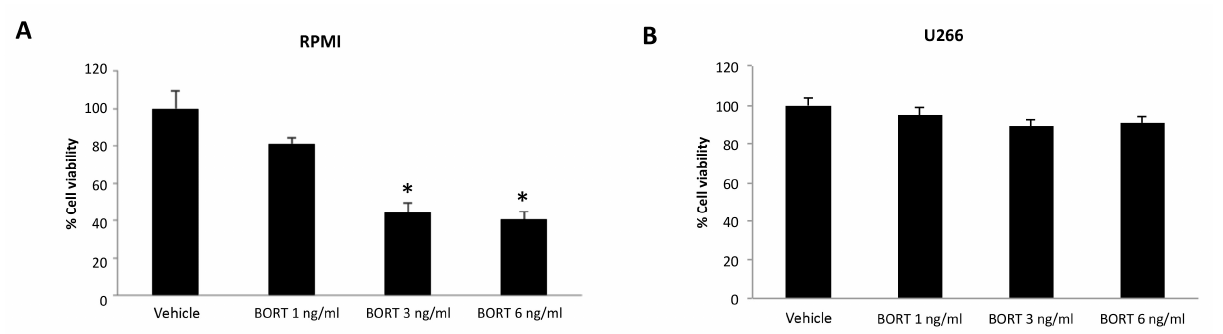
Figure 5. Cell viability assay in RPMI ( A ) and U266 ( B ) treated for 48 h with Bortezomib (BORT). Data are the mean ± SD of three different experiments. * p < 0.05 vs. vehicle-treated cells. Furthermore, we evaluated the effects of Bortezomib-Ibrutinib combination in both MM cell lines. U266 and RPMI cells were treated with Bortezomib 3 and 6 ng/mL and Ibrutinib 5 or 12.5 μ M suboptimal doses alone and in combination for 48 h (Figure 6A,B).